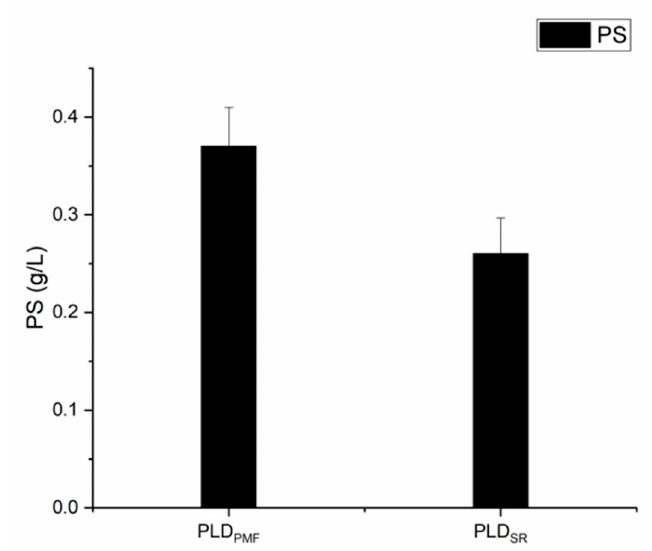
Figure 1. Comparison of the transphosphatidylation activity of the phospholipase D (PLD) coming from Streptomyces PMF and S. racemochromogenes when expressed in E. coli .